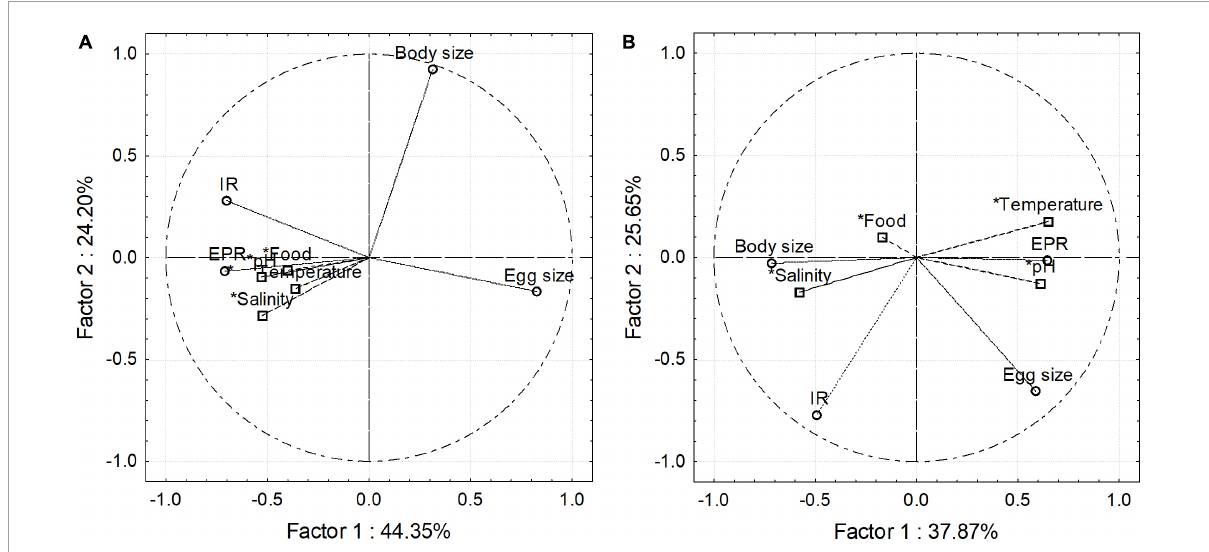
FIGURE5 Environmental–biological coupling in the estuarine (A) and upwelling (B) habitat explored through Principal Component Analysis. Besides explaining a higher proportion of the observed variance, PCA in the estuarine habitat also indicates biological cues, especially physiological ones correlated among